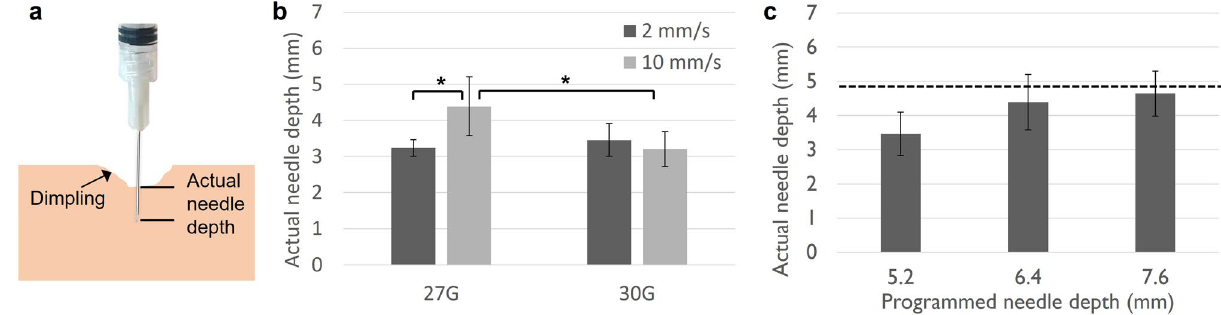
Figure 1. Optimizing needle insertion to minimize dimpling. ( a ) Schematic illustrating that dimpling leads to lower actual needle depths compared to the programmed needle depth. ( b ) Relationship between needle gauge, needle insertion rate, and actual needle depth in the swine cervix for a programmed needle depth of 6.4 mm. A 27-gauge needle and insertion rate of 10 mm/s achieved the highest actual needle depth. ( c ) Relationship between programmed needle depth and actual needle depth in a swine cervix for a 27-gauge needle and an insertion rate of 10 mm/s. A programmed needle depth of 7.6 mm achieved an actual needle depth close to a target of 4.8 mm (indicated by dashed line). All groups had a sample size of n = 4 to 5. *p <